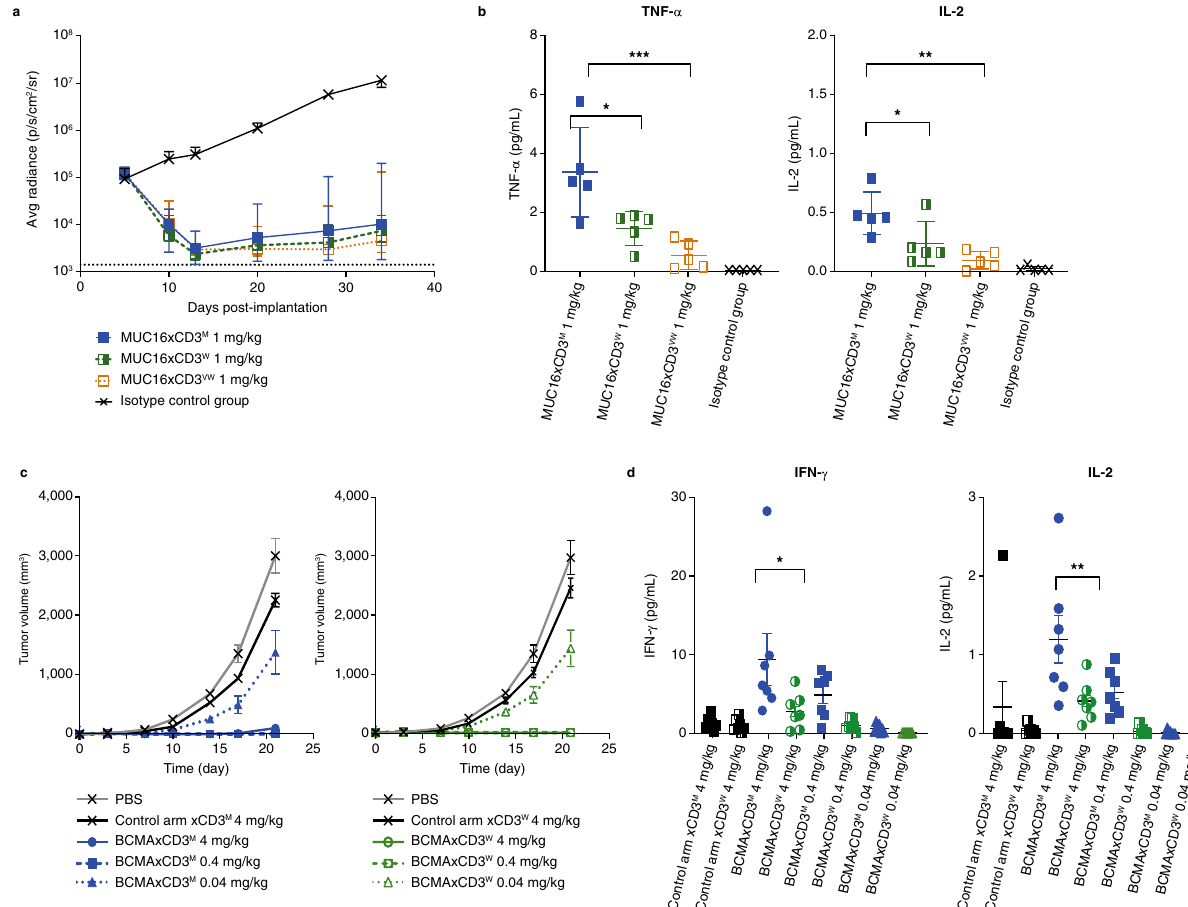
Figure 7. Reduction of tumor burden, unlike cytokine serum accumulation, is CD3 affinity-independent in xenogenic tumor models. ( a ) NSG mice were injected with 5 × 10 6 human PBMCs before 1 × 10 6 ascites cells from the OVCAR-3/luc cell line were administered IP (day 0). Mice were dosed IV with MUC16xCD3 bispecific antibodies or isotype control antibodies at 1 mg/kg, and imaged multiple times throughout the study to track tumor burden; ( b ) serum samples from the OVCAR-3/luc experiment were collected at 4 h post-dose to examine cytokine concentrations by MSD; ( c ) NSG mice were subcutaneously implanted with a mixture of human peripheral blood cells (1 × 10E 6 cells) and MOLP-8 tumor cells (5 × 10E 6 cells), and animals were continuously dosed IP twice weekly with BCMAxCD3 bispecific antibodies or controls through day 21, at various doses (4 mg/kg, 0.4 mg/kg, 0.04 mg/kg); ( d ) four hours post-implantation, serum from the MOLP-8 experiment was harvested for cytokine analysis by MSD. statistical analysis by ordinary one-way ANOVA with Tukey’s multiple comparisons test. * P < 0.05, ** P < 0.002, and *** P < 0.0003. Avg average; BCMA B-cell maturation antigen; d day; IP intraperitoneally; IV intravenously ; luc luciferase; m moderate; MSD Meso Scale Diagnostics; MUC16 Mucin-16 for ovarian cancer; NSG NOD scid gamma; PBMC peripheral blood mononuclear cell; PBS phosphate-buffered saline; vw very weak; w